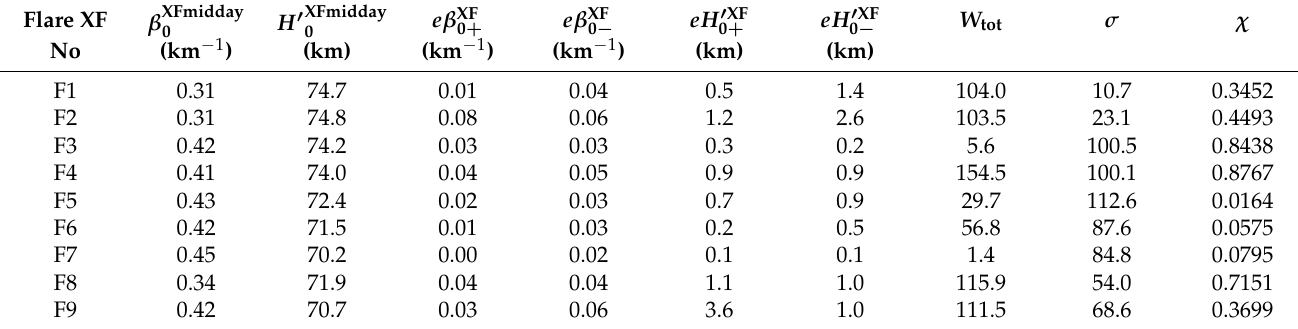
, and signal reflection height, H (cid:48) XFmidday , and domains of 0 0 and eH (cid:48) XF ) and lower values ( e β XF and eH (cid:48) XF ) for the considered flares. The 0 + 0 + 0 − 0 −